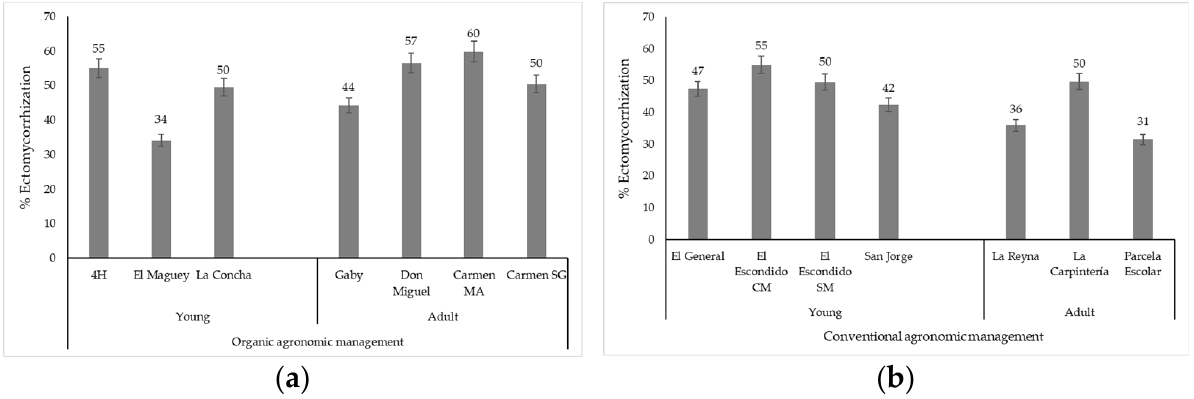
Figure 2. Correlation of agronomic management method and tree age with respect to the percentage of ECM ( p ≤ 0.05) in the roots of Western Schley pecan trees [ Carya illinoinensis (Wangeh) K. Koch] of 3 to 48 years old, established in Chihuahua State, Mexico. ( a ) Organic agronomic management; ( b ) conventional agronomic management. ( p ≤ 0.05). Young = 3 to 20 years old. Adult = greater than 20 years old.